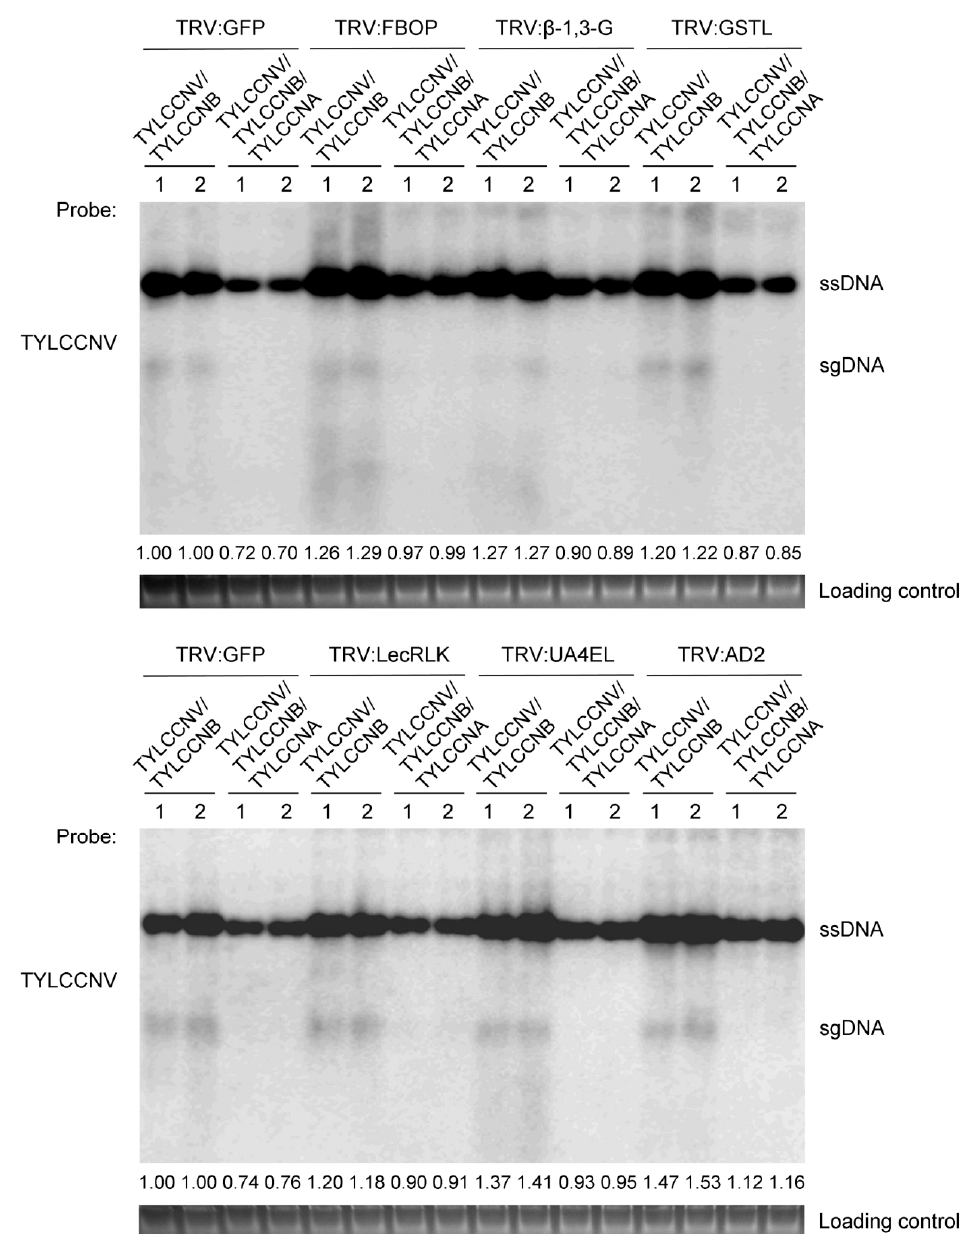
Figure 8. Accumulation levels of TYLCCNV in VIGS-silenced N. benthamiana plants infected with TYLCCNV / TYLCCNB or TYLCCNV / TYLCCNB / TYLCCNA at 14 dpi. The accumulation levels of TYLCCNV in VIGS-silenced N. benthamiana seedlings were determined by Southern blot shown in Figure 8. Total genomic DNA (approximately 10 μ g for each lane) from a mixture of four seedlings was used for Southern blot analysis. Blots were probed with the coat protein gene sequence of TYLCCNV. An ethidium bromide-stained gel shown below the blots provides a DNA-loading control. The positions of single stranded (ssDNA) and subgenomic (sgDNA) forms of TYLCCNV are indicated, respectively. Quantitative assessment was processed by Quantity One Software (http: //